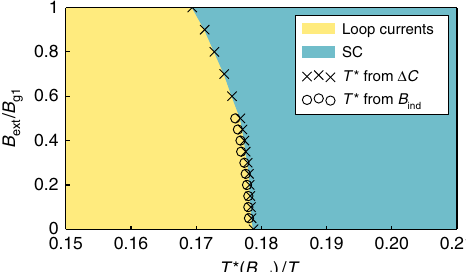
Fig. 7 Phase diagram. The transition temperature T * to a state with spontaneously broken continuous translational symmetry is plotted as a function of the external magnetic fl ux density. The crosses show T * extracted from the jump in the speci fi c heat in Fig. 6e, while the open circles show T * extracted from the minimum of the total induced magnetic fl ux in Fig.